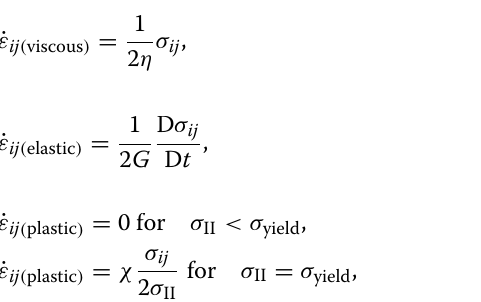
0. Initial friction angle and = 0 and ε II 1 to = =